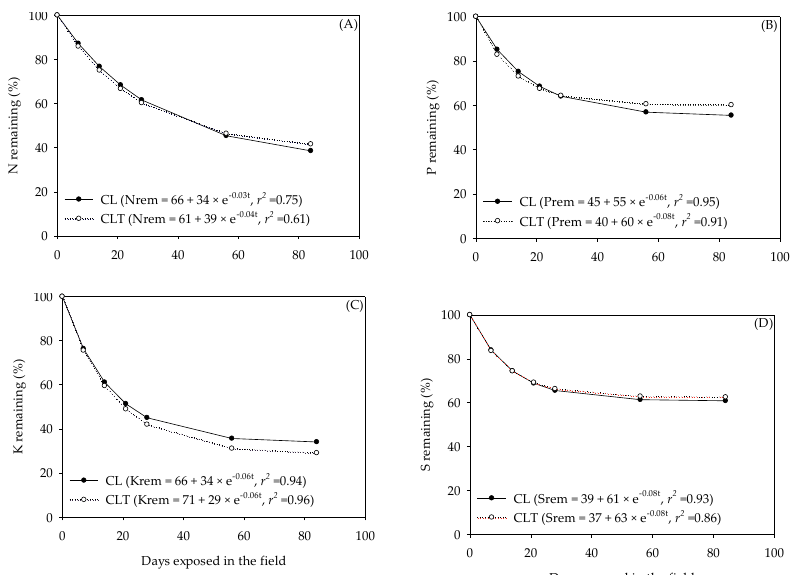
Figure 6. Nitrogen (N), phosphorus (P), potassium (K) and sulphur (S) remaining from the cattle dung residue, during exposure into the pasture (i.e., Lolium multiflorum + Avena strigosa ; A , B , C and D ) as affected by the systems (CL, crop–livestock and CLT, crop–livestock–trees). Dry matter or N, P, K and S remaining (rem) = res + act e −kt . res , resistant fraction; act , active fraction; k , non–linear decay rate; t , time; r² , coefficient of determination.